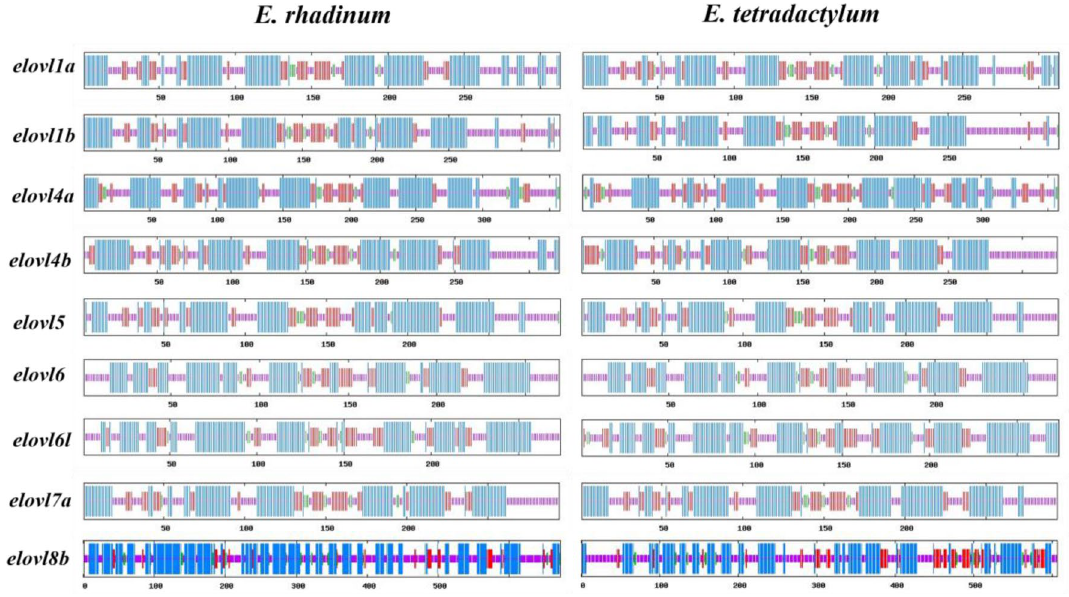
Figure 3. The secondary structure pattern, including alpha helix (blue color), random coil (purple color), extended strand (red color), and beta turn (green color), of Elovl proteins in E. tetradactylum and E. rhadinum